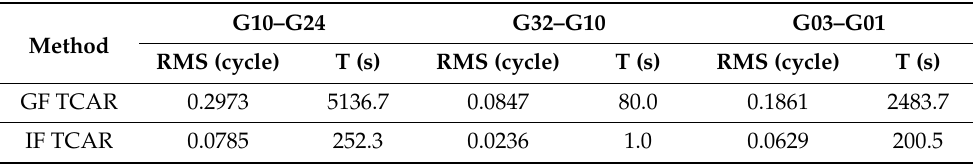
Figure 9. Ambiguity residual of L1 signal by GF TCAR method (upper row) and IF TCAR method (lower row) and corresponding elevation angles with GPS data ( a , d ) are the GF and IF of G10– G24; ( b , e ) are the GF and IF of G32–G10; ( c , f ) are the GF and IF of G03–G01.